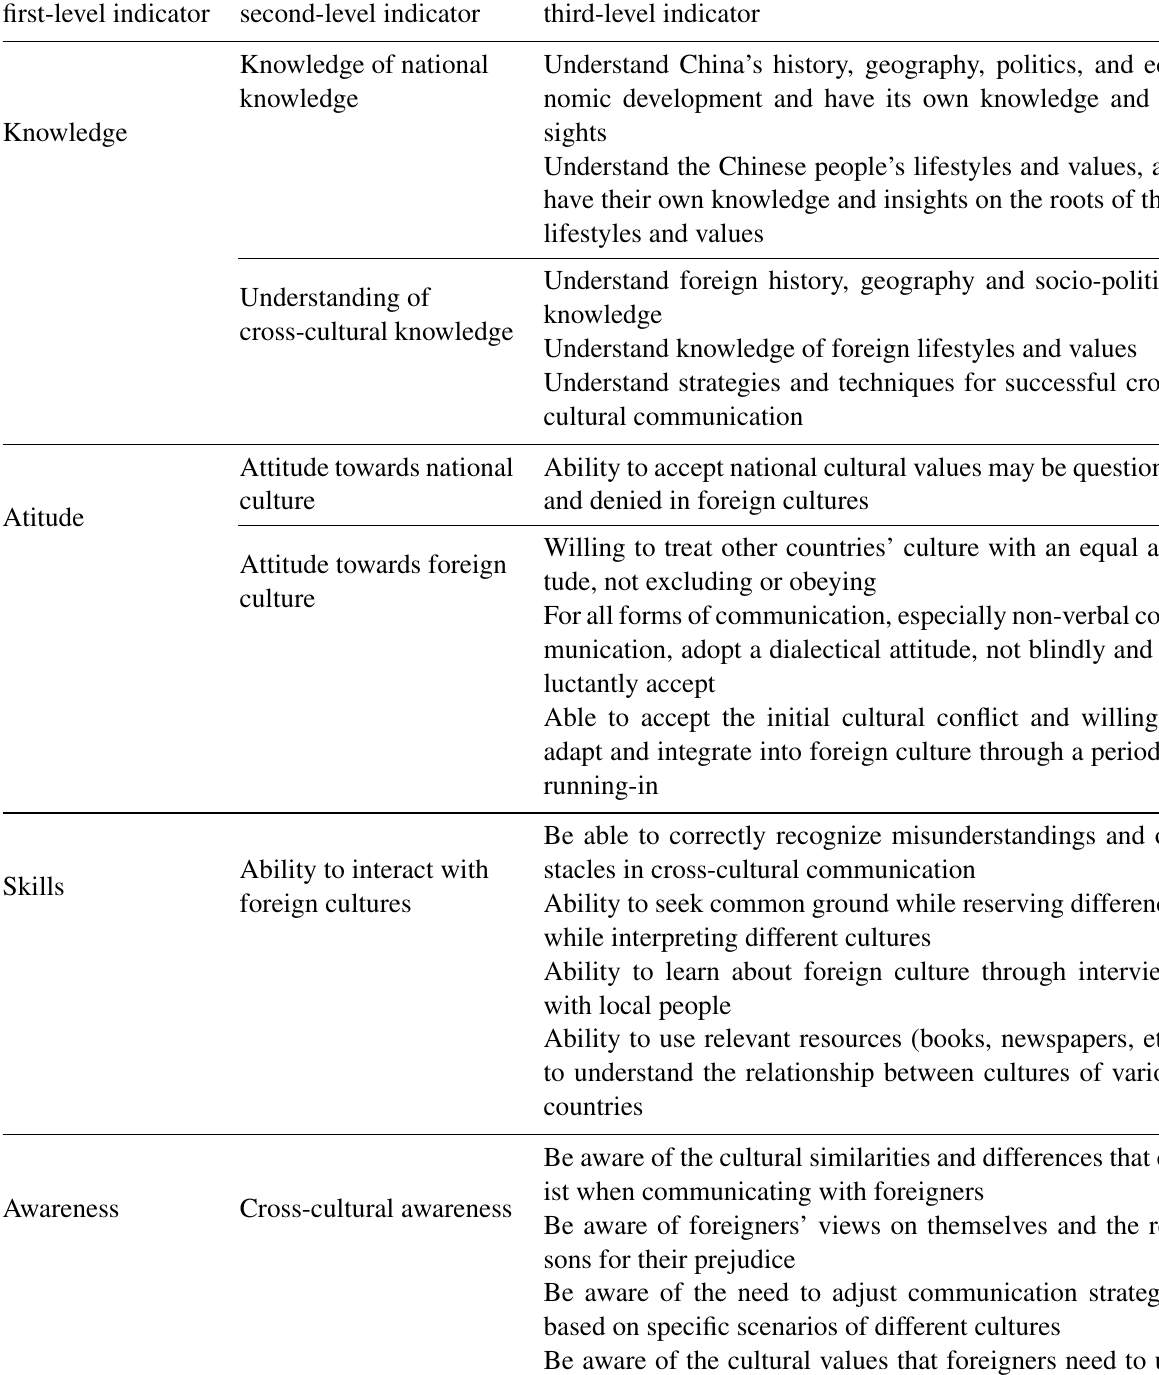
Table 3 Evaluation System of Intercultural Ability of Civil Aviation College